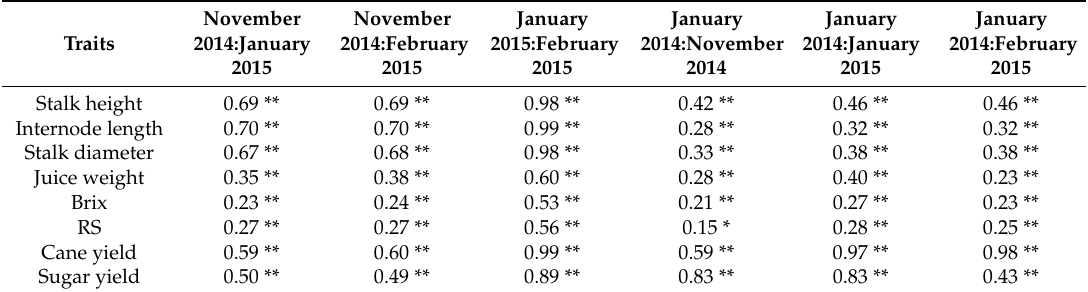
Table 2. Correlation coefficients among months for the different traits measured in two seasons of the collection of